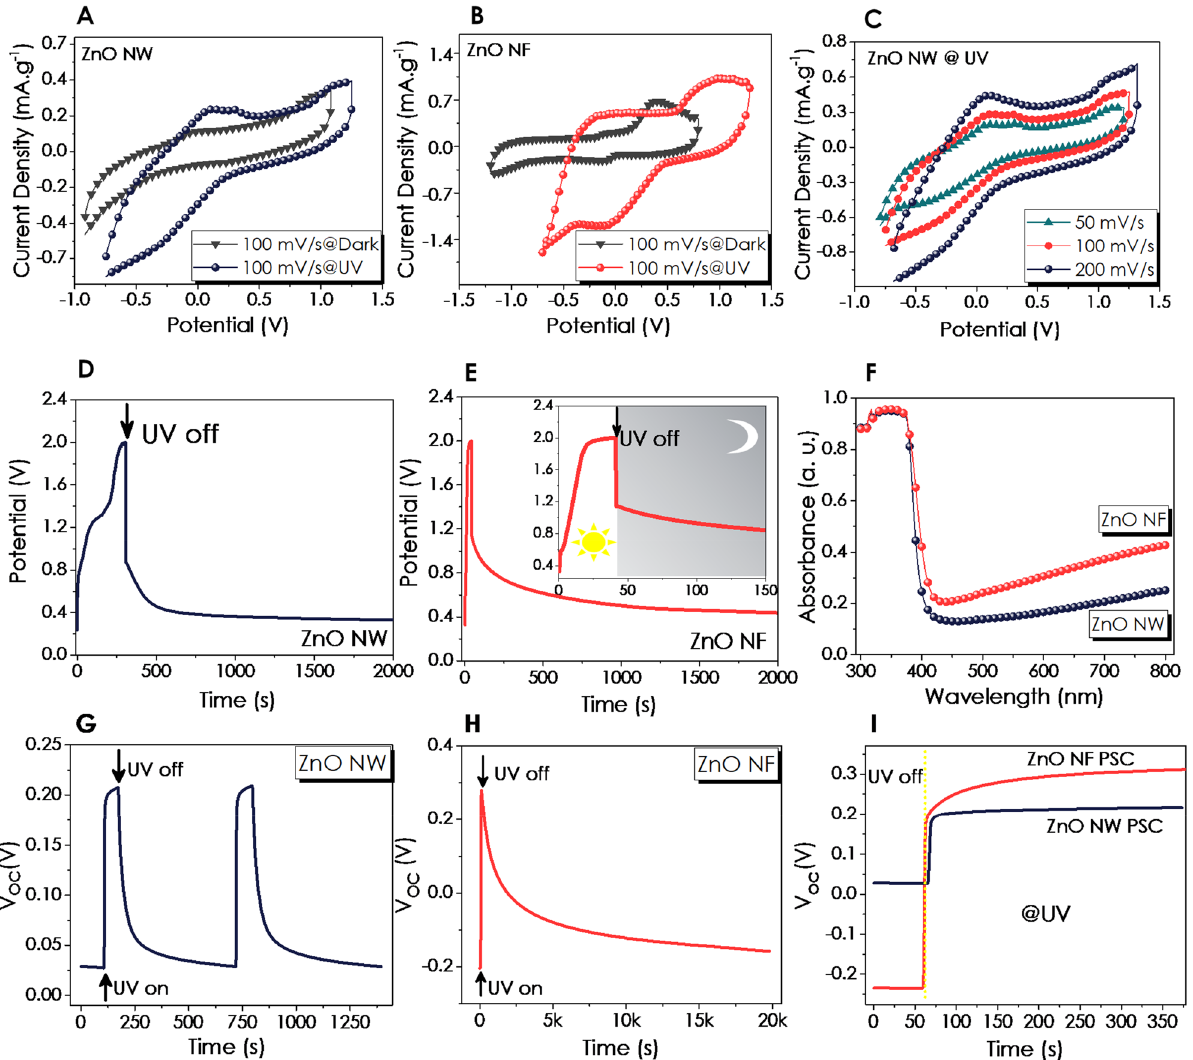
Figure 4. CV curves of (A) ZnO NW and (B) ZnO NF at dark and UV conditions, ( C ) ZnO NW at UV with various scan rates. The curves for photo-charging (at 0.55 mA g −1 )/self-discharge in the dark under zero applied current after long-term GCD measurements; ( D ) ZnO NW, ( E ) ZnO NF, ( F ) UV–Vis Absorbance curves for both thin-film P-SC devices; Changes in open circuit potential (V OC ) under UV illumination and dark conditions for ( G ) ZnO NW, ( H ) ZnO NF and ( I ) Comparison for V OC at dark and under UV illumination for 5